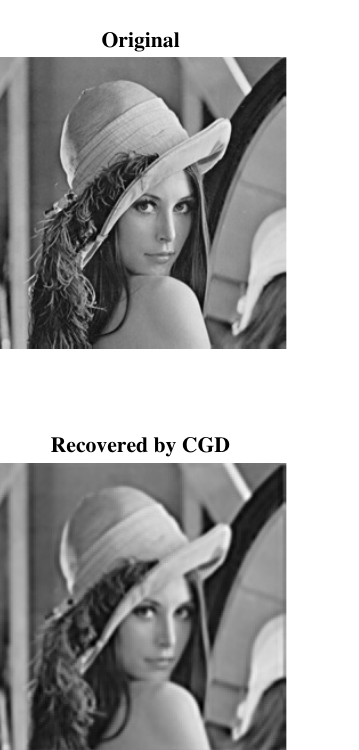
Figure 5. The original image ( top left ), the blurred image ( top right ), the restored image by CGD ( bottom left ) with SNR = 20.05, SSIM = 0.83 and by DCG ( bottom right ) with SNR = 20.12, SSIM = 0.83.